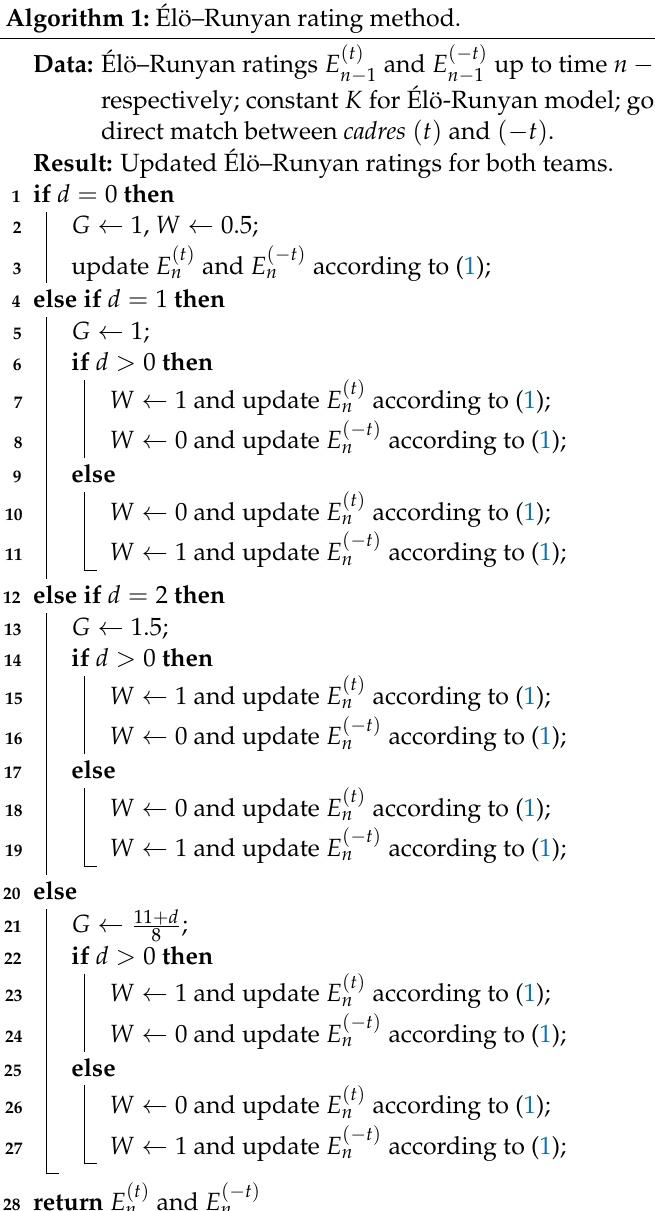
Algorithm 1: Élö–Runyan rating